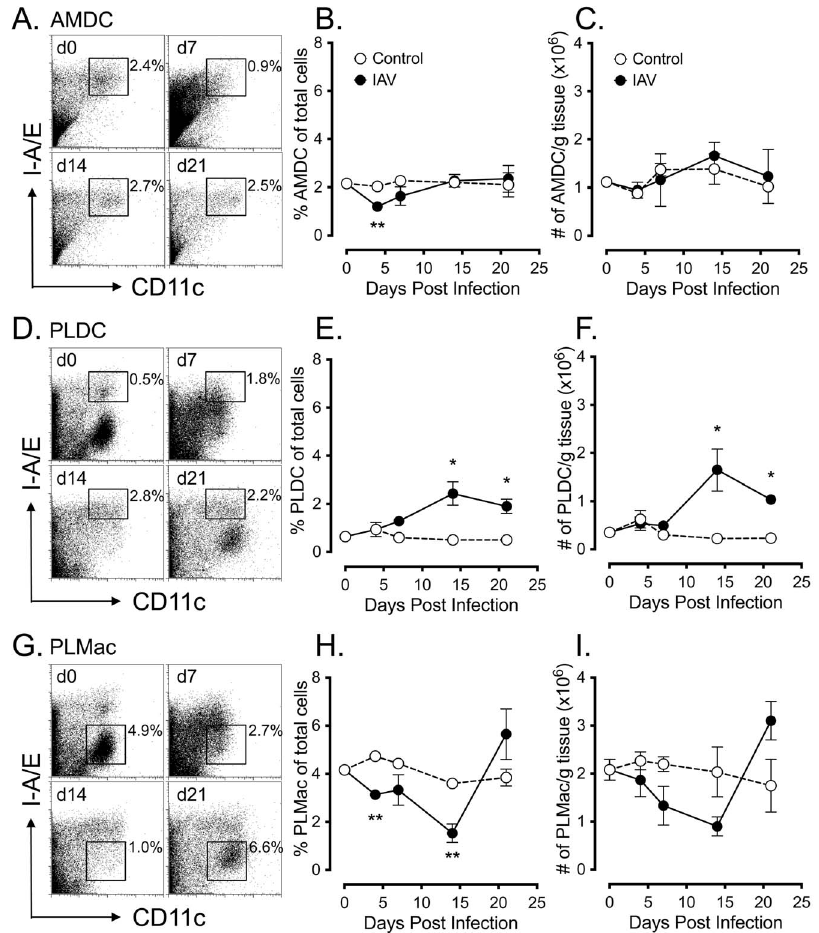
Figure 4. Kinetics of airway mucosal and parenchymal lung DC changes following IAV infection. (A) Representative FACS profiles showing gating for AMDC at the indicated time points p.i. (B and C) AMDC percentage frequencies (B) and total numbers (C) following IAV infection for control (open circles) and IAV infected mice (closed circles). (D) Representative FACS profiles showing gating for PLDC at the indicated time points p.i. (E and F) PLDC percentage frequencies (E) and total numbers (F) following IAV infection for control (open circles) and IAV infected mice (closed circles). (G) Representative FACS profiles showing gating for PLMac at the indicated time points p.i. (H and I) PLMac percentage frequencies (H) and total numbers (I) following IAV infection for control (open circles) and IAV infected mice (closed circles). Data are means + / 2 SEM for 3 independent infection experiments using pools of tissue from 3 to 4 mice for each experiment. * = p , 0.05; ** = p , 0.01.